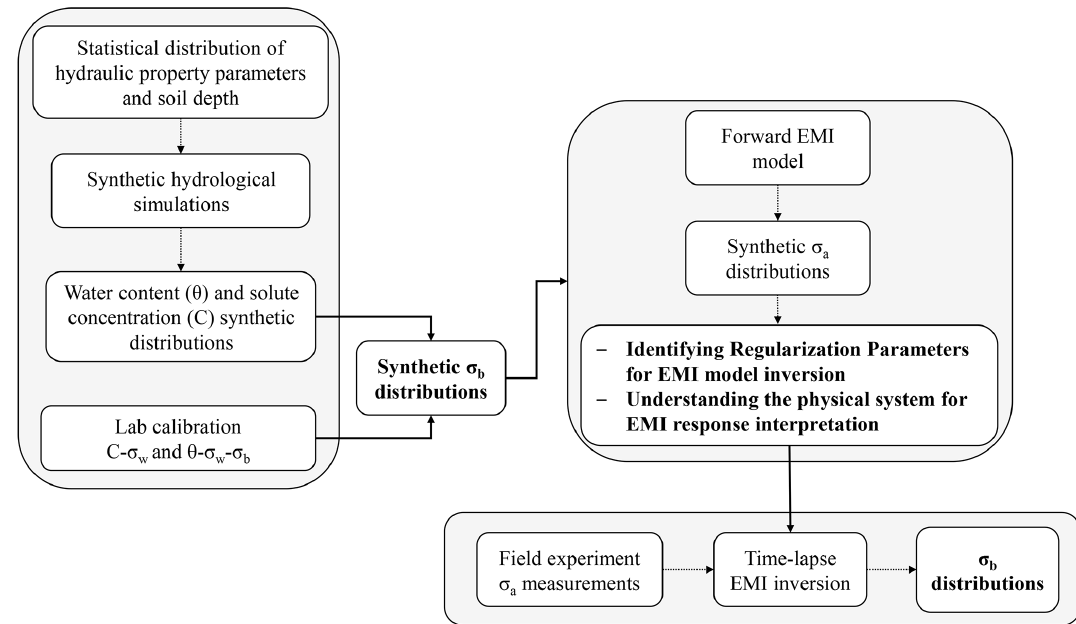
Figure 4. Flow chart of the applied procedure, with the key steps in bold. The procedure is explained in detail in the text.